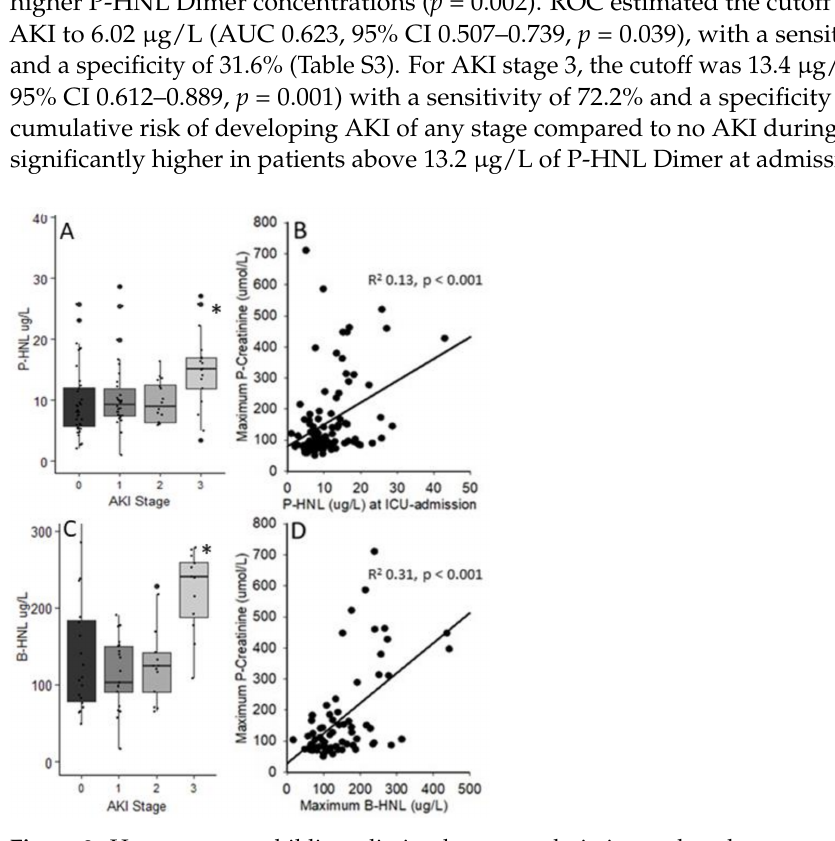
Figure 2. Human neutrophil lipocalin in plasma at admission and peak concentrations in whole blood during intensive care vs. acute kidney injury stage and plasma creatinine. A one-way ANOVA ( A ) demonstrating that P-HNL Dimer at admission differed between AKI stages ( p = 0.010); however, post-hoc analysis indicated the main difference to be between no AKI and AKI stage 3 * ( p = 0.006, Bonferroni-adjusted). The plasma creatinine concentration increased as P-HNL Dimer increased significantly ( B ). The biomarker could explain 13% of the variation in creatinine. A one-way ANOVA of AKI stage and B-HNL ( C ) was also significant ( p < 0.001). Post-hoc analysis revealed a difference between no AKI, AKI stage 1, and AKI stage 2 separately with AKI stage 3 * ( p = 0.002, p < 0.001, and p = 0.003, Bonferroni-adjusted). Plasma creatinine increased with peak B-HNL concentrations, ( D ) and the biomarker could explain 31% of the variation in plasma